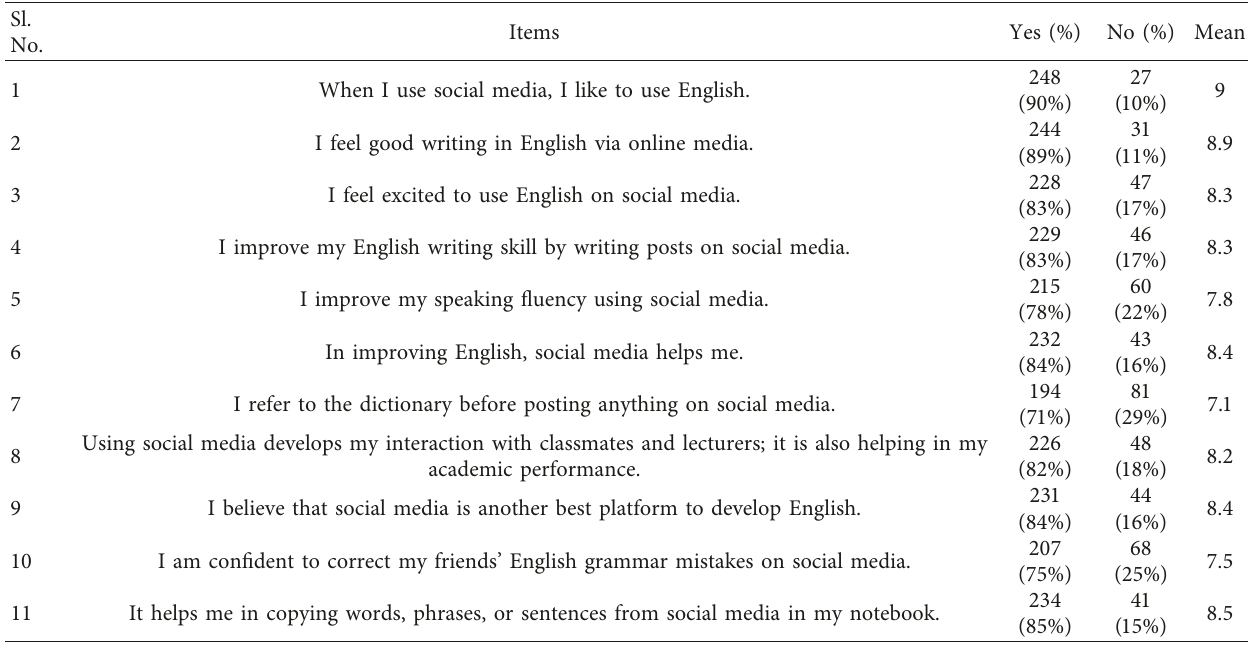
Table 7: Allocation, frequency, and mean on the respondents’ perception of the usage of English language while using social media. Sl.